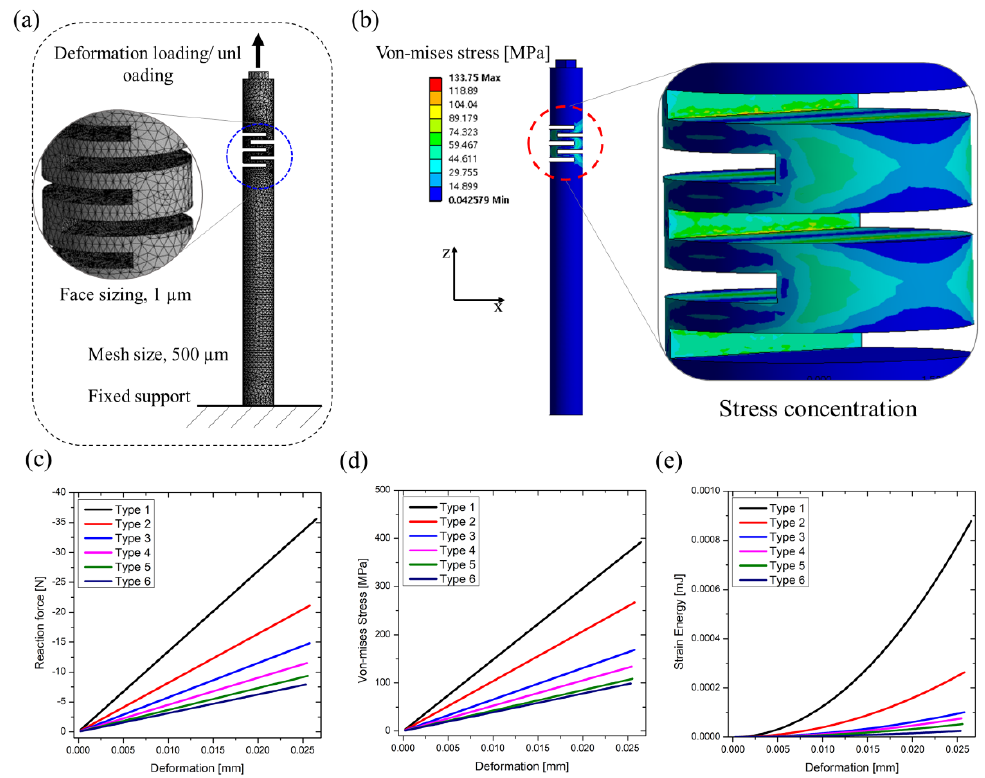
Figure 4. Static simulation results of the flexure hinge; ( a ) Simulation setup, ( b ) Distribution of the Von-mises stress along with the flexure hinge and stress concentration on each slit; the plotted graphs of ( c ) Reaction force at the fixed support versus deformation, ( d ) Von-mises stress versus deformation, and ( e ) Strain energy versus deformation.